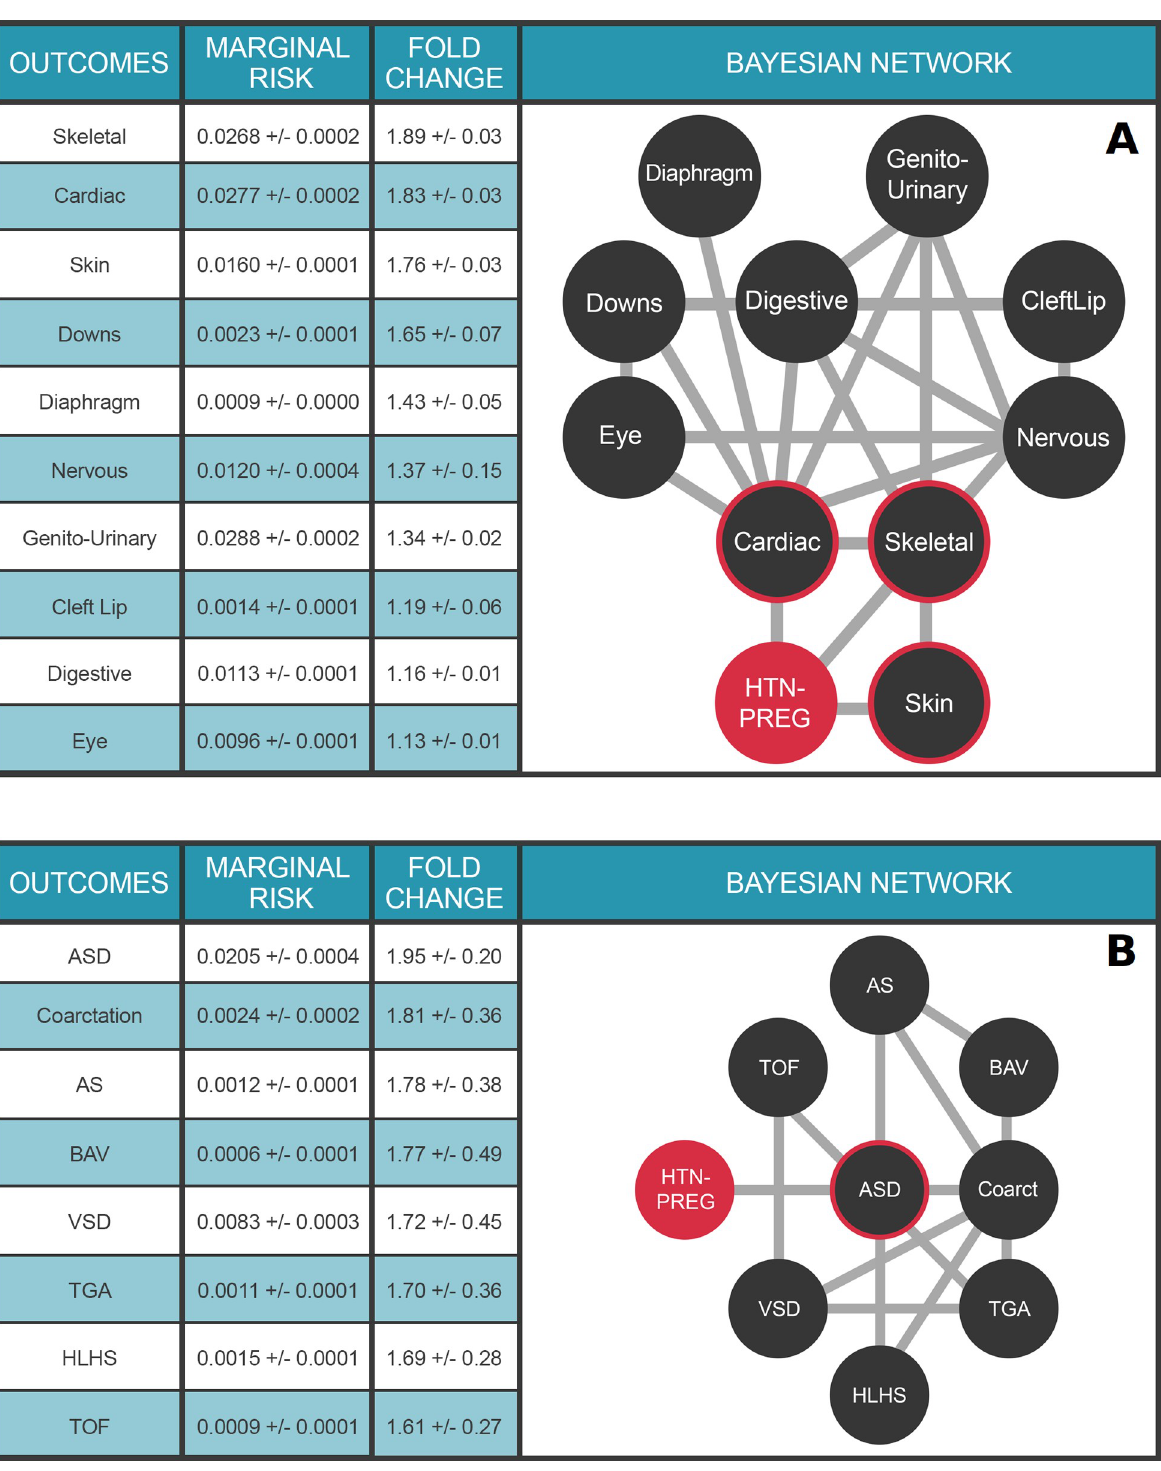
PLOS Digital Health | https://doi.org/10.1371/journal.pdig.0000004 January18,